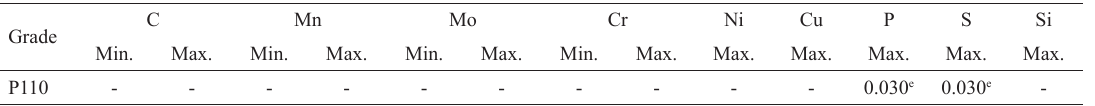
Table 1: Chemical specifications of the API 5CT grade P110 steel(wt%).